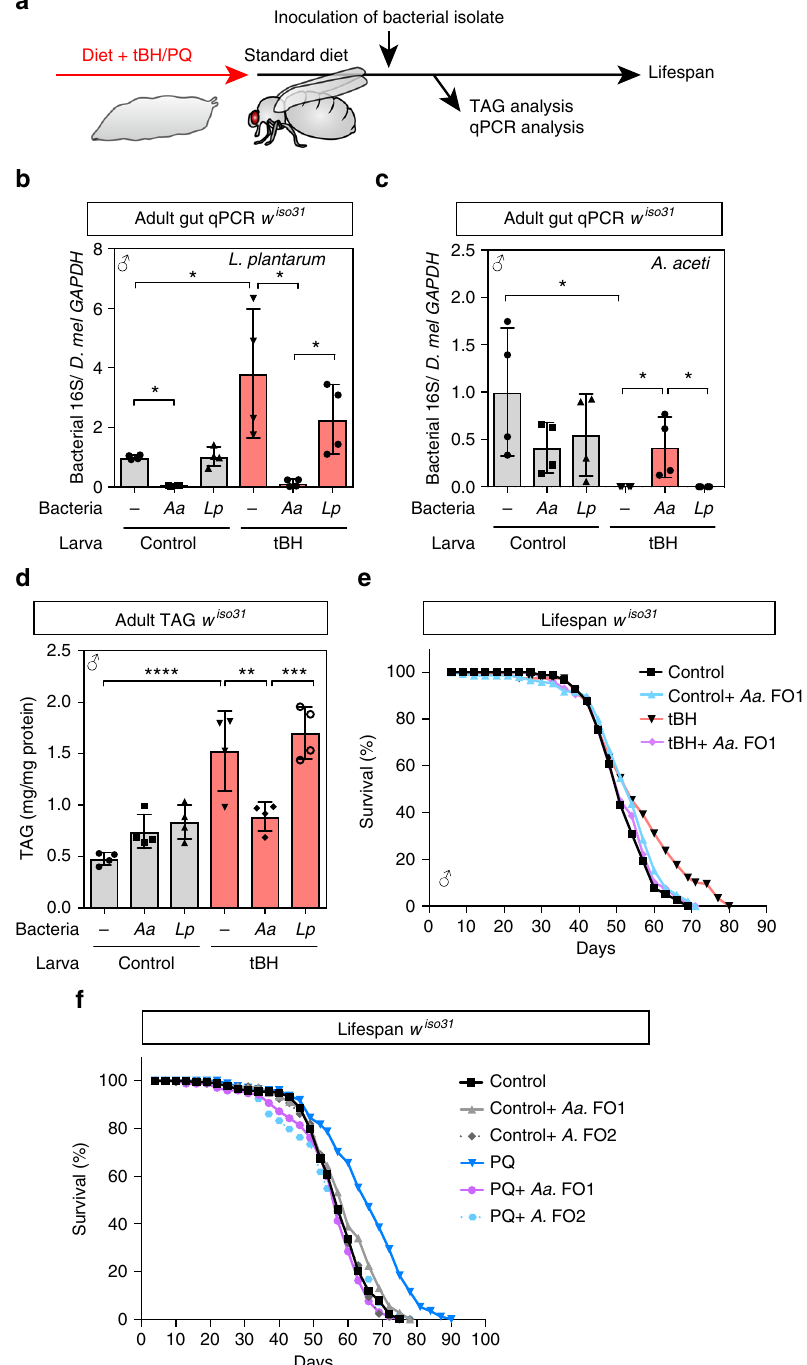
Fig. 7 Acetobacter decreases TAG stores and shortens lifespan. a Experimental strategy for adult inoculation of bacterial isolates to tBH-experienced fl ies. b , c Quantitative PCR of bacteria in w iso31 male fl ies raised as larvae on control (grey) or tBH (5 mM, red) diets and inoculated with MRS medium only ( − ), A. aceti FO1 ( Aa ) or L. plantarum FO3 ( Lp ). Mean ± SEM ( n = 4). d , e Whole-body TAG ( d ) and lifespan ( e ) of inoculated w iso31 male fl ies raised on 5 mM tBH. d Mean ± SEM ( n = 4). f Lifespan of inoculated w iso31 male fl ies raised on 1 mM PQ. Either A. aceti FO1 or Acetobacter FO2 is inoculated in adult stage. * p < 0.05, ** p < 0.01, *** p < 0.001, **** p < 0.001. Statistics for the survival lifespan experiments are shown in Supplementary Table